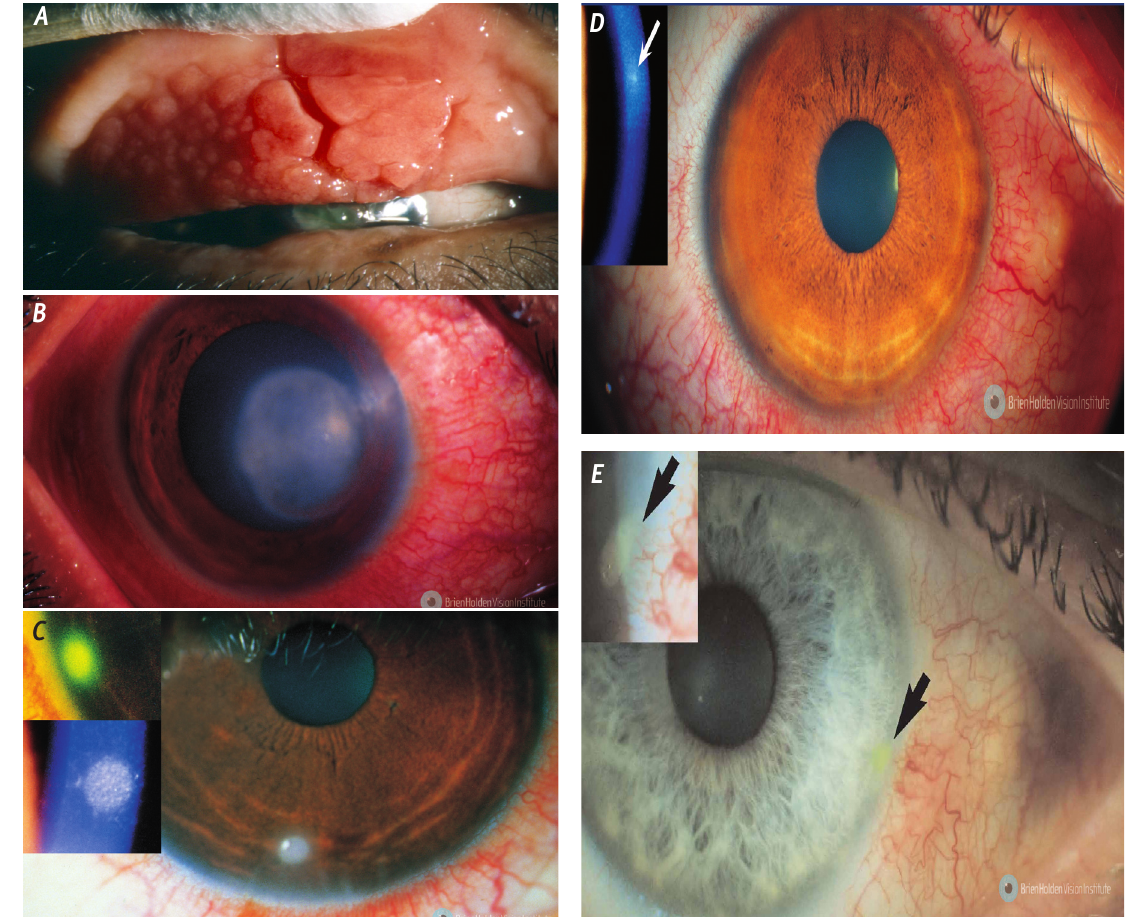
Figure 1. Contact lens-associated